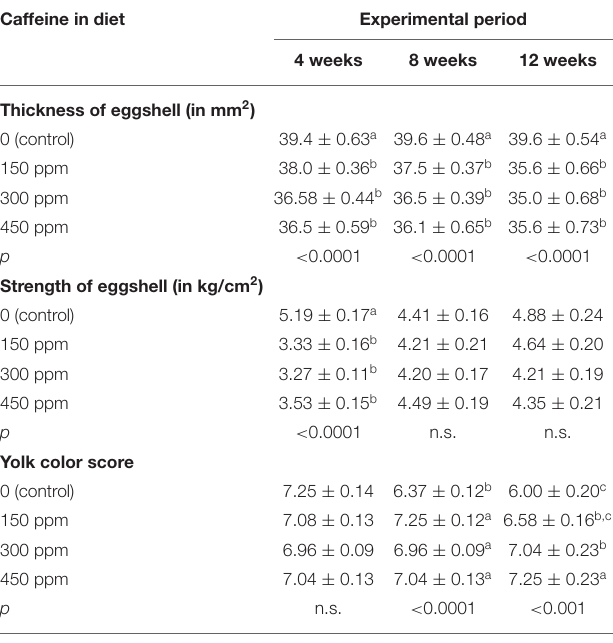
TABLE 7 | Thickness and strength of the eggshell and the yolk color score of the eggs produced by laying hens fed rations containing different concentrations of caffeine for 12